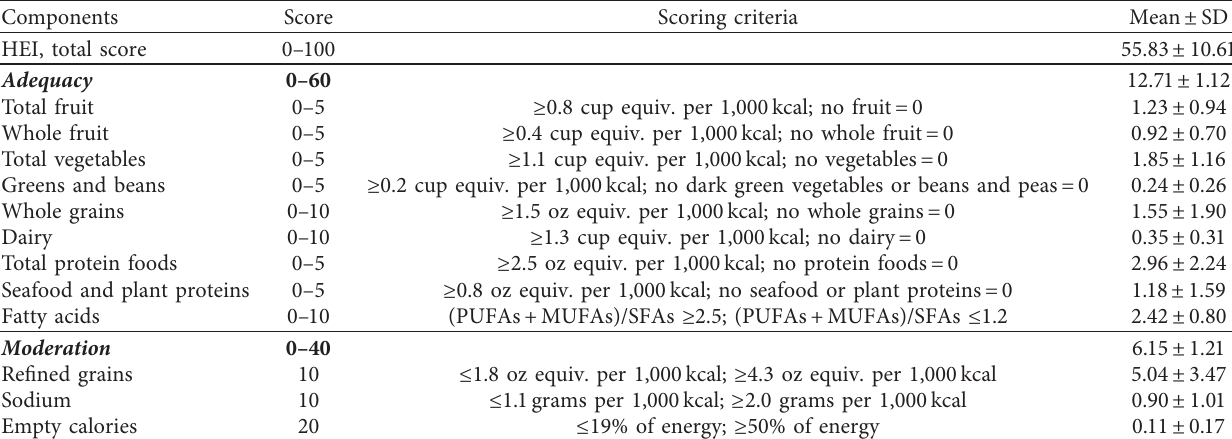
Table 4: Healthy Eating Index (HEI-2010) components and criteria used for maximum score and zero score ( n �